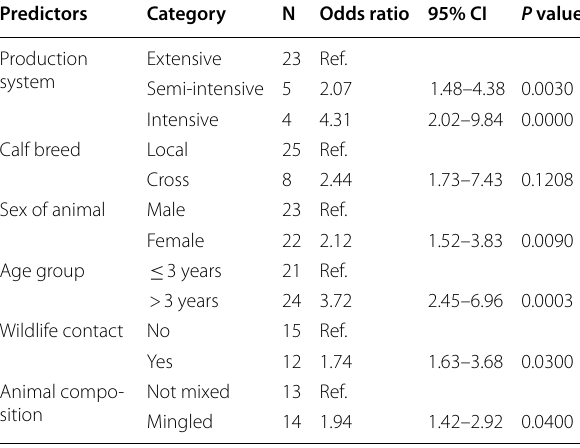
Table 4 Multivariable meta-regression on the prevalence of foot and mouth disease in